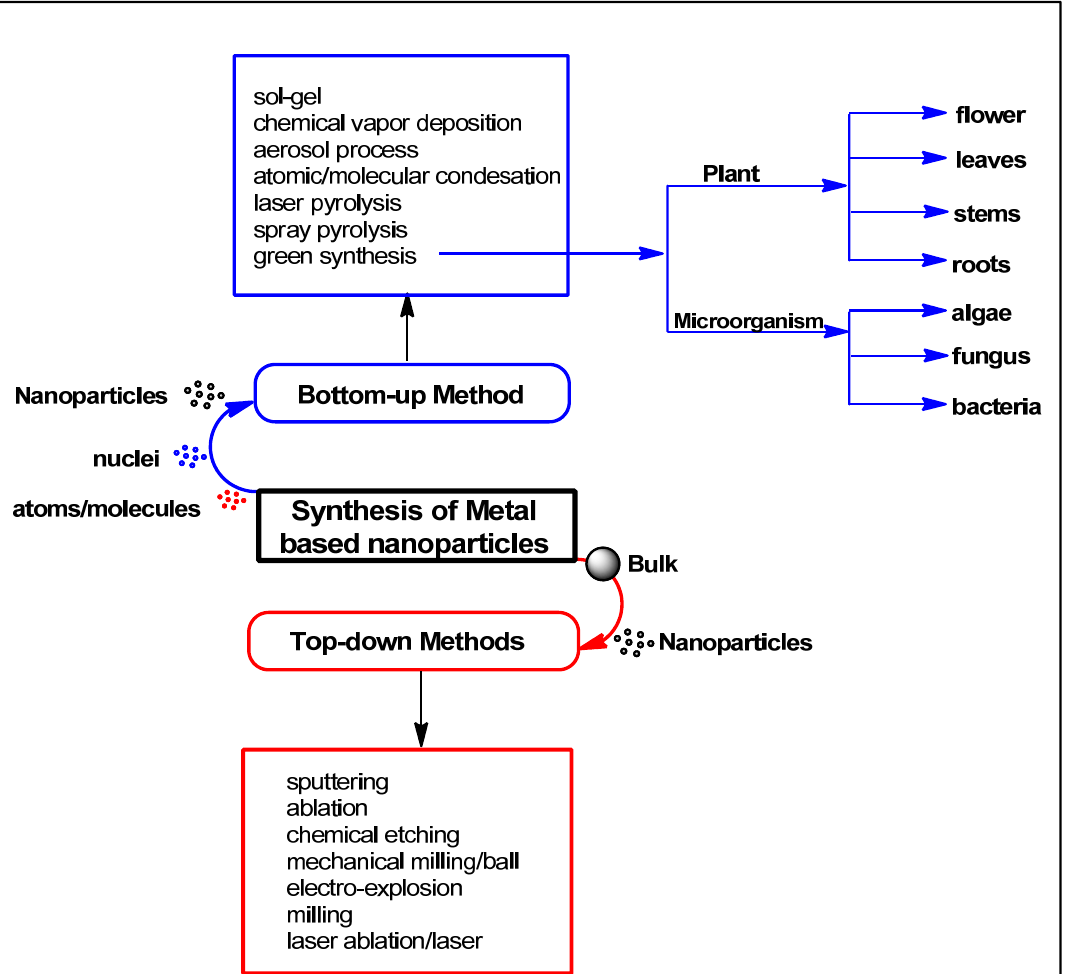
Figure 1. Different reported synthetic approaches for metal ‐ based nanoparticles. Redrawn from [21], with permission from Elsevier (Copyright 2022).